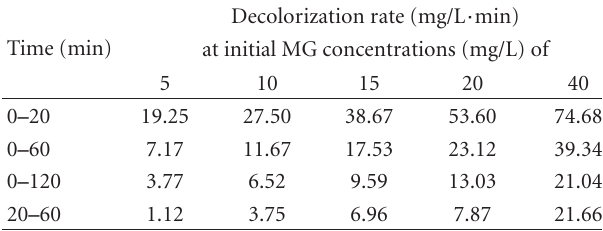
Table 1: Decolorization rate (mg/L · min) at di ff erent initial concen- trations of MG at [Glucose] 0 = 1 g/L, [enzyme] 0 = 1000 U/L, [Fe 2+ ] 0 = 10mM, and T = 30 ◦ C.